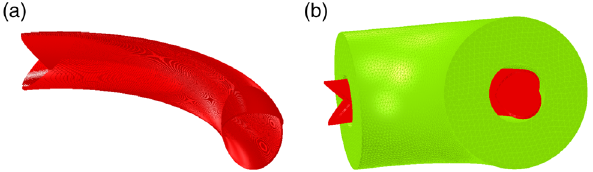
iron.FIG. 4. 3D view of the coil winding (a) and shielding iron (b) of the superconducting 90° combined-function